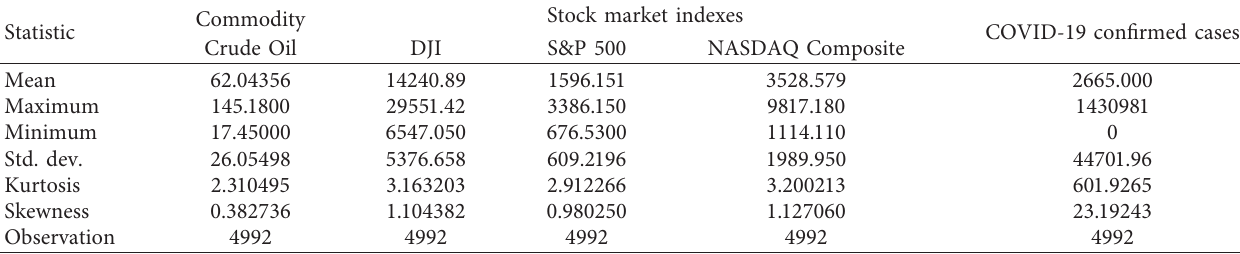
Table 1: Descriptive statistics of commodity, stock market indexes, and COVID-19 confirmed